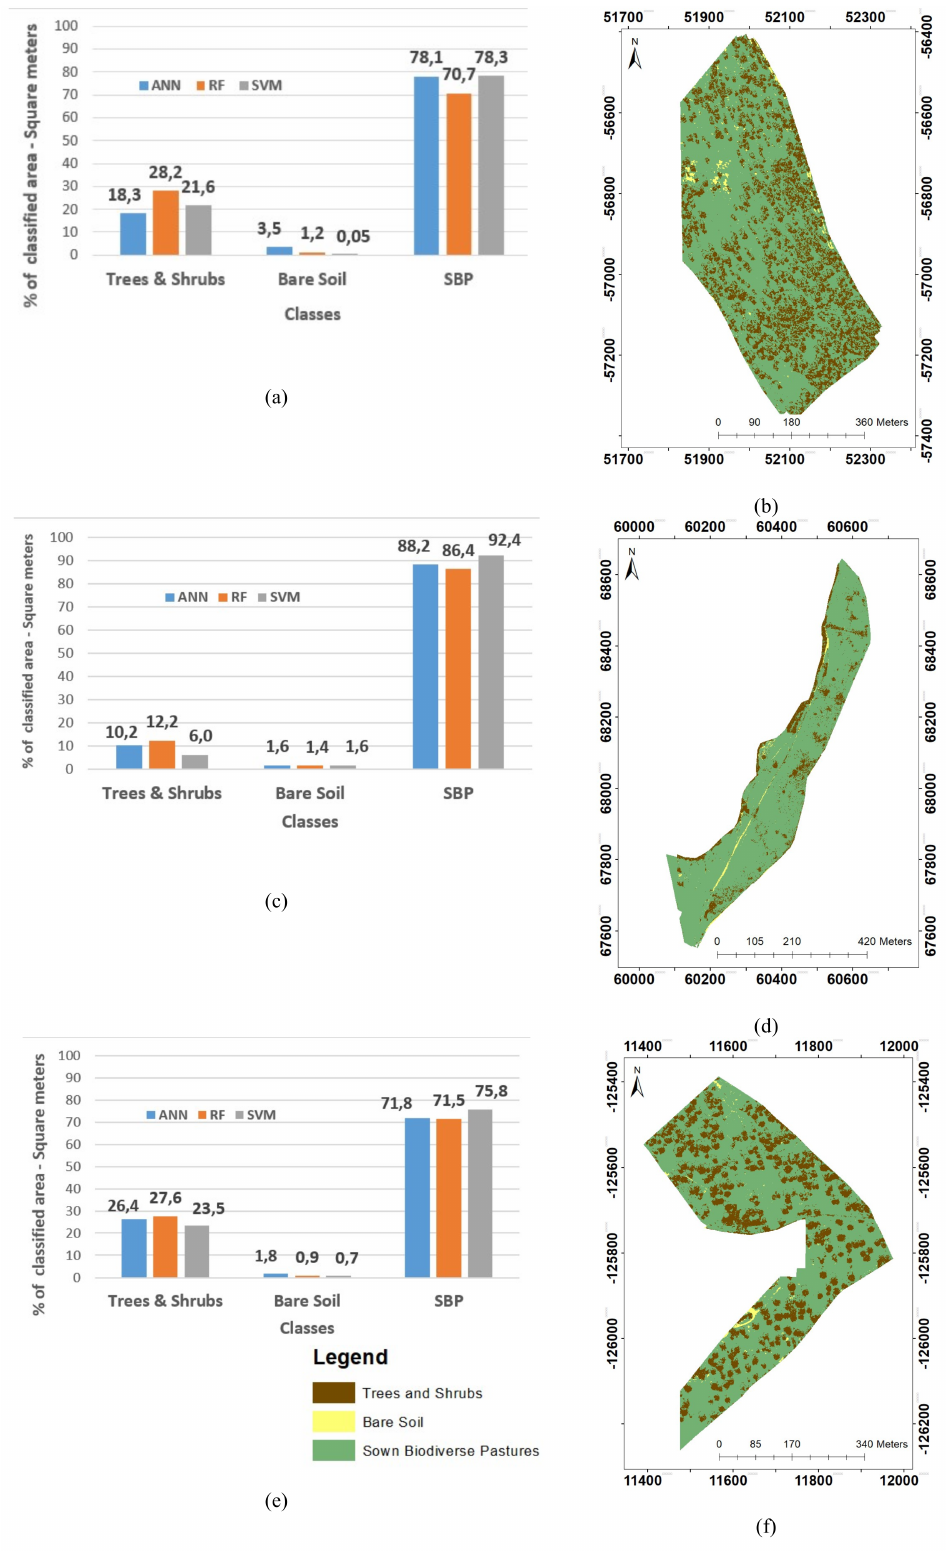
Figure 6. Relative distribution of land classes in each farm ( a —farm 1, c —farm 2 and e —farm 3) using multitemporal classification with Artificial Neural Networks (ANN), Random Forest (RF) and Support Vector Machine (SVM) algorithms, and respective spatial distribution within each farm for the case of the RF classifier ( b —farm 1, d —farm 2 and f —farm 3). SBP—Sown Biodiverse